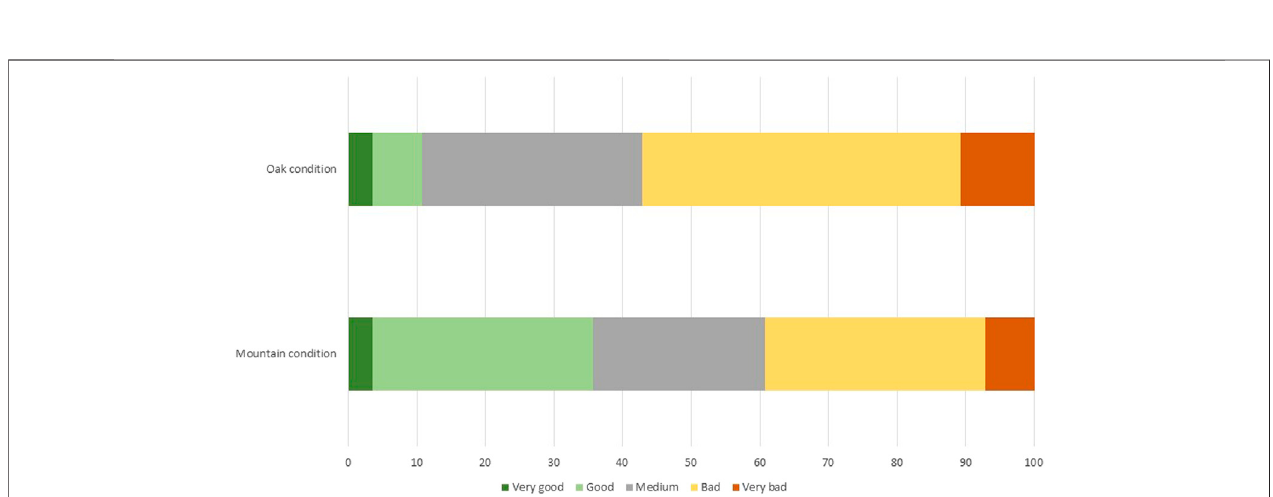
FIGURE 2 | Perception of oaks ’ and mountains ’ conditions of La Puebla de la Sierra.